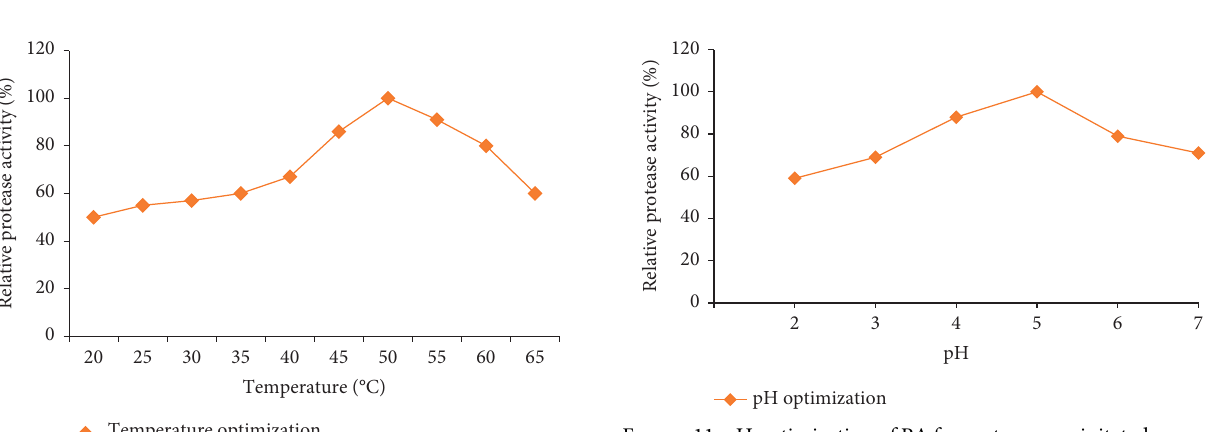
Figure 9: Temperature optimization of PA for acetone-precipitated enzyme from the isolate Z1BL1.